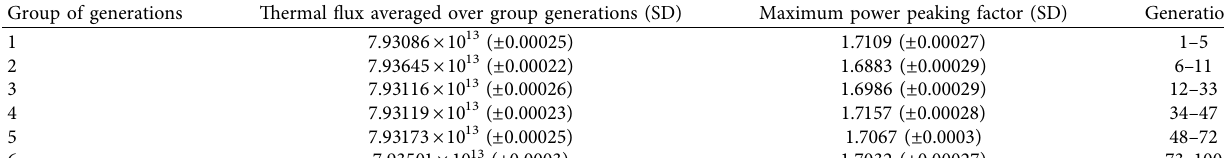
Table 7: Group generations having the same optimal thermal flux values.